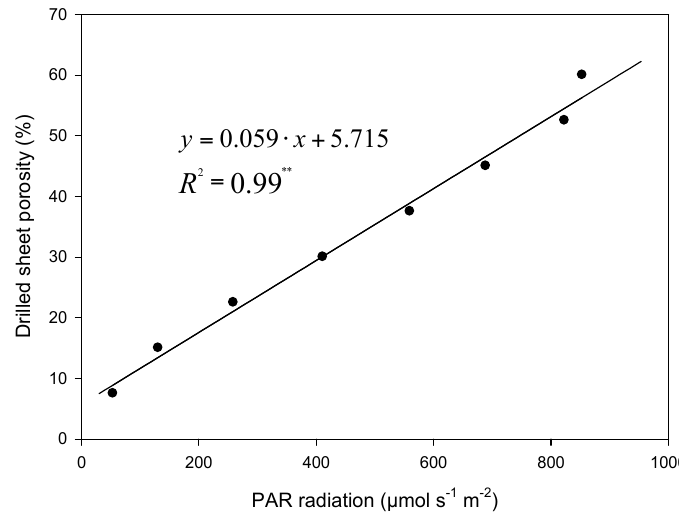
Figure 2. Sunscan calibration and regression between PAR and porosity using drilled sheets to shade the probe.